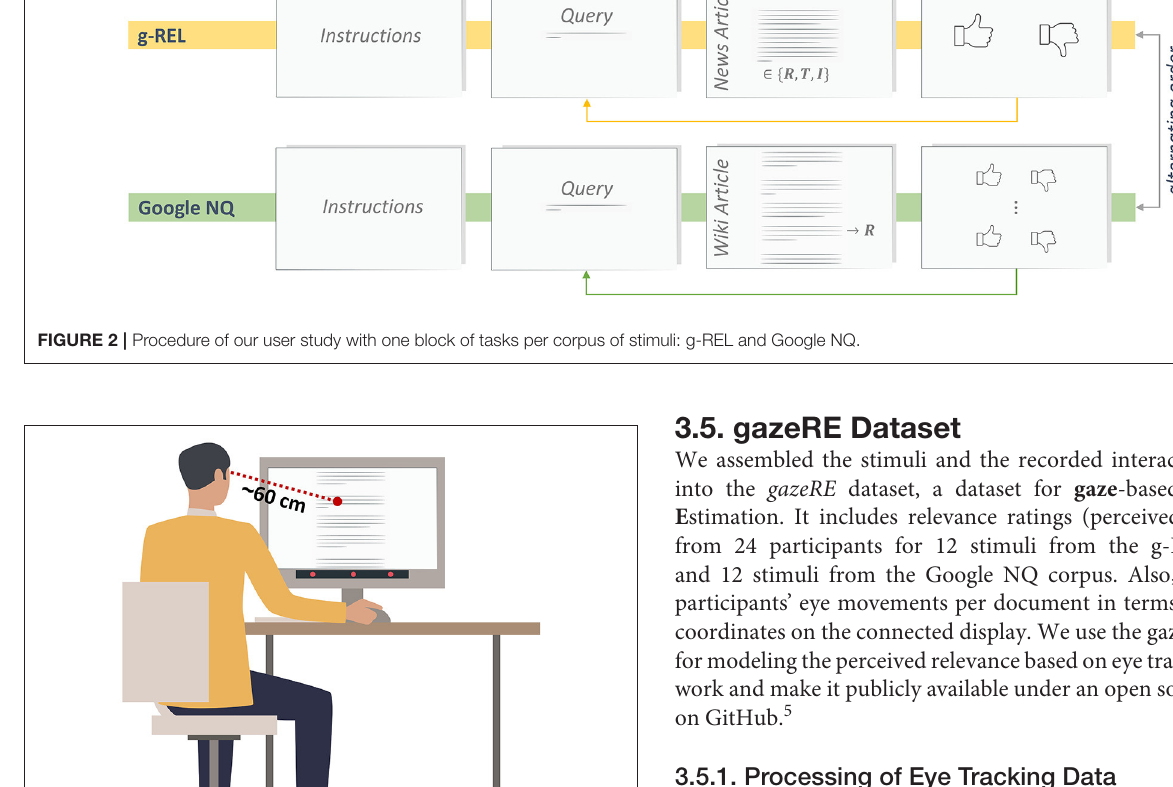
eye tracker collects the gaze data with a sampling rate of 90